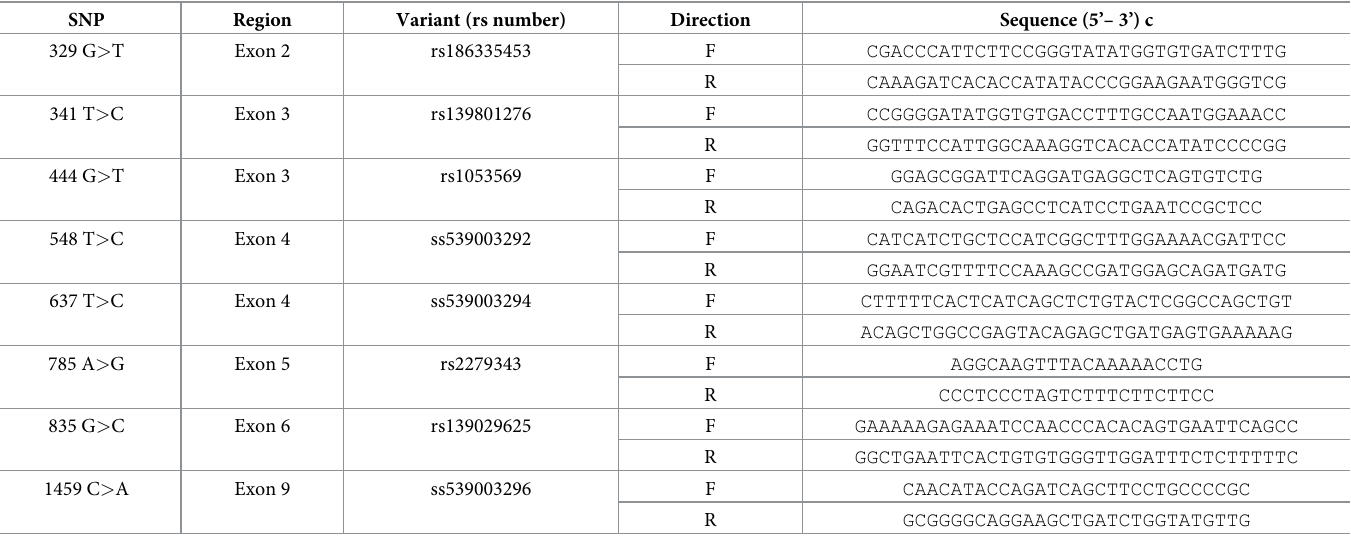
Table 1. List of CYP2B6 SNPs primers used for genotyping in this study (Radloff et al., 2013) [21].